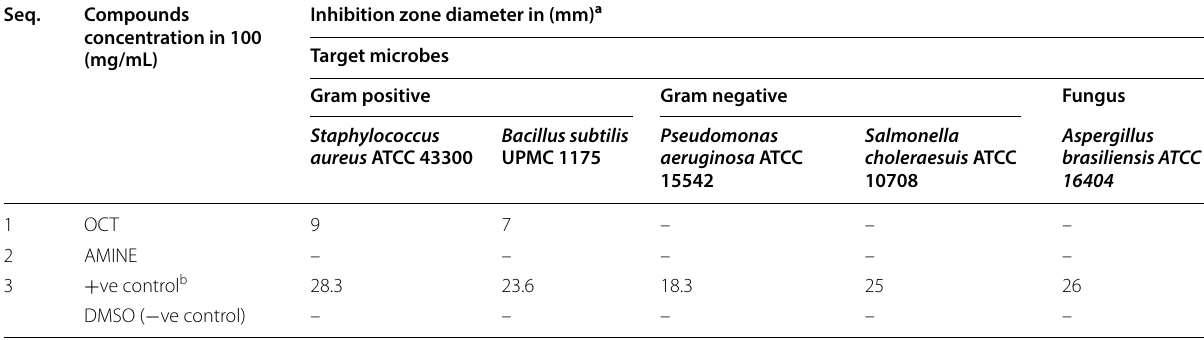
Values are given as mean of triplicate experiment –, no inhibition was observed a Diameter of inhibition zones including diameter of 5 mm well b Tetracycline or nystatin in case of antibacterial and antifungal respectively